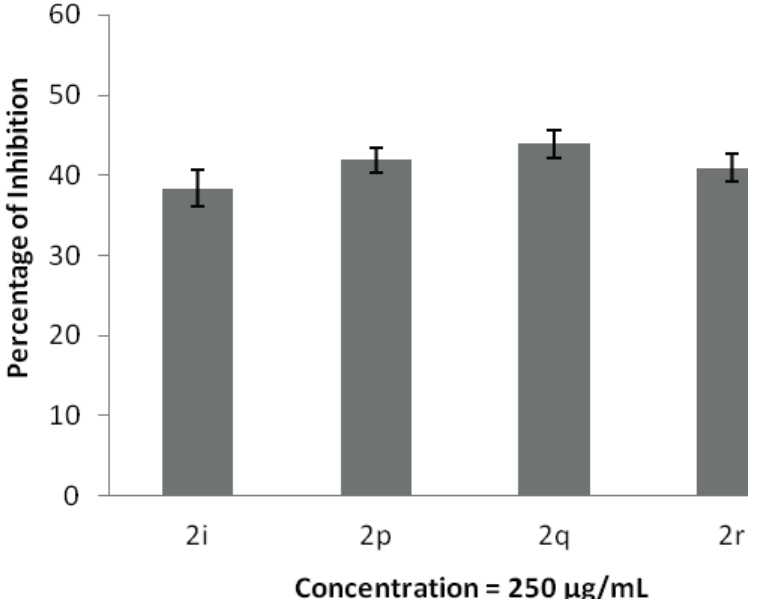
Figure 9. Inhibition of protein denaturation. The data represent the percentage of hydrogen peroxide radical inhibition (mean ± SD), and experiments were performed in